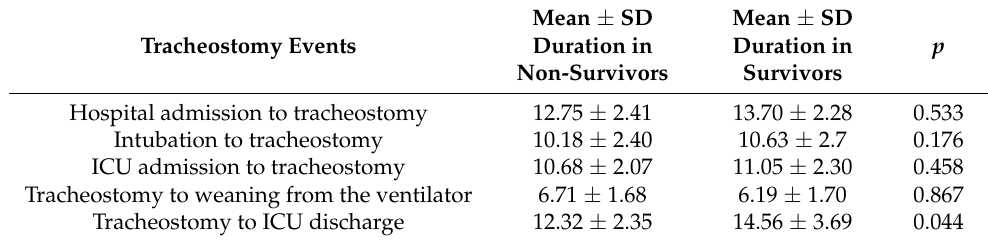
Table 5. Comparison of tracheostomy-related events between survivors and